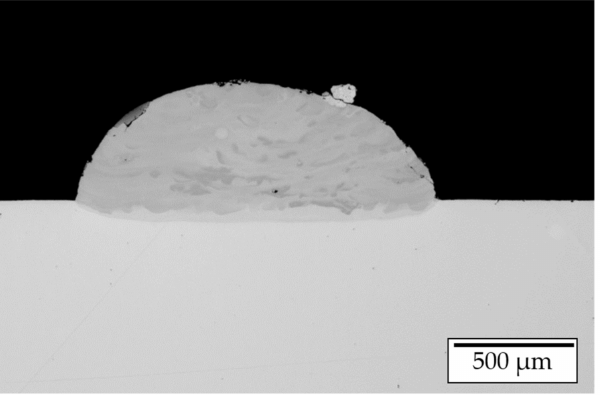
Figure 14. LOM image of a single track manufactured by in-situ alloying of elemental Ni and Al.